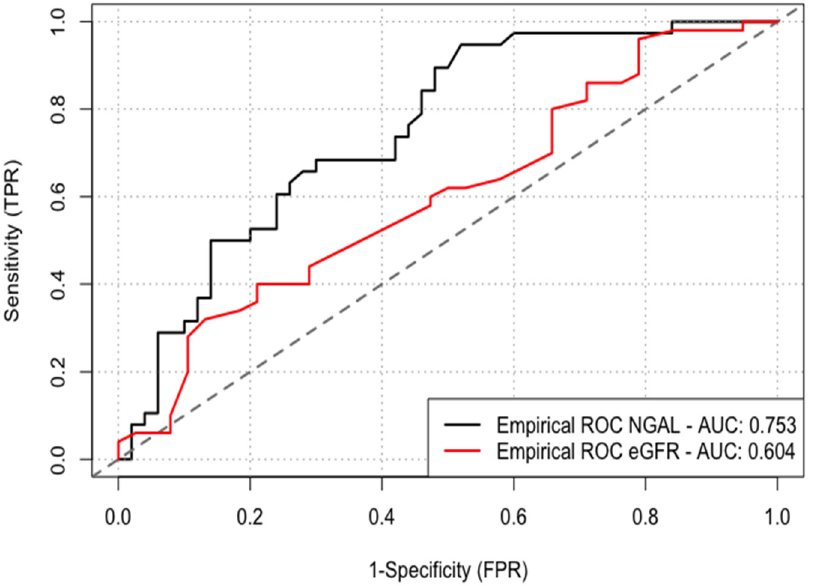
Figure 2. ROC curve analysis was performed to identify the optimal cutoff point of serum NGAL levels and eGFR for the prediction of CI-AKI. NGAL, neutrophil gelatinase-associated lipocalin; eGFR, estimated glomerular filtration rate; CI-AKI, contrast-induced acute kidney injury. Hazard ratios with corresponding 95% confidence intervals of the univariate and multivariate binary logistic regression for the development of CI-AKI are summarized in Table 2. In a multivariate logistic regression model, serum NGAL levels >127 ng/mL were independently associated with CI-AKI (HR 9.84, 95% CI: 1.96–40.3; p = 0.01). Other factors associated with CI-AKI included age, smoking history, and CRP. Table 2. Univariate and multivariate logistic regression models for the prediction of acute kidney injury. CI-AKI Presense No